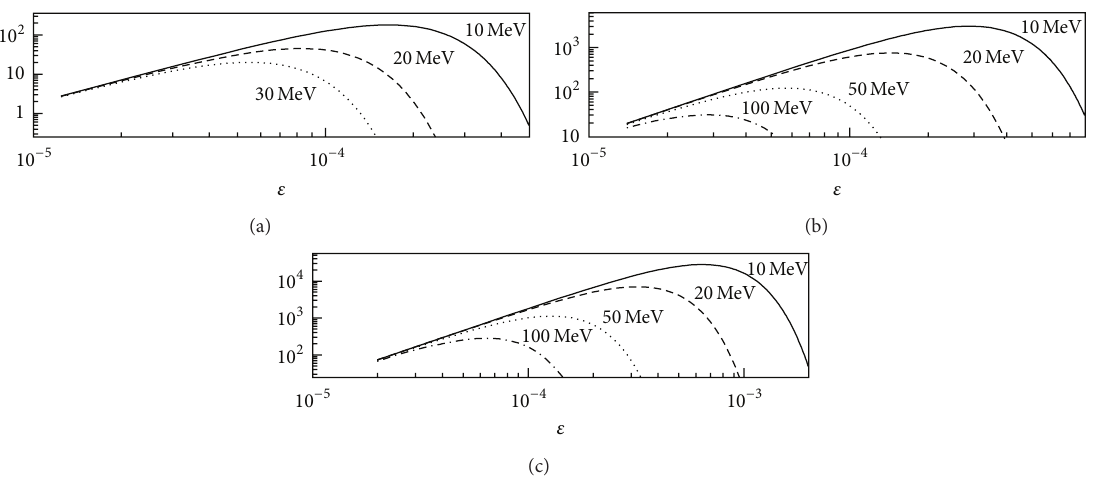
Figure 2: Number of 𝛾 󸀠 decay events with transverse decay path larger than 1cm, as a function of 𝜖 , for different values of 𝑚 𝛾 󸀠 . Three different experimental conditions are taken into consideration: (a) 𝐸 = 50 ab −1 . Note that the horizontal scale is slightly different for the three plots. 10.5 GeV, 𝐿 int